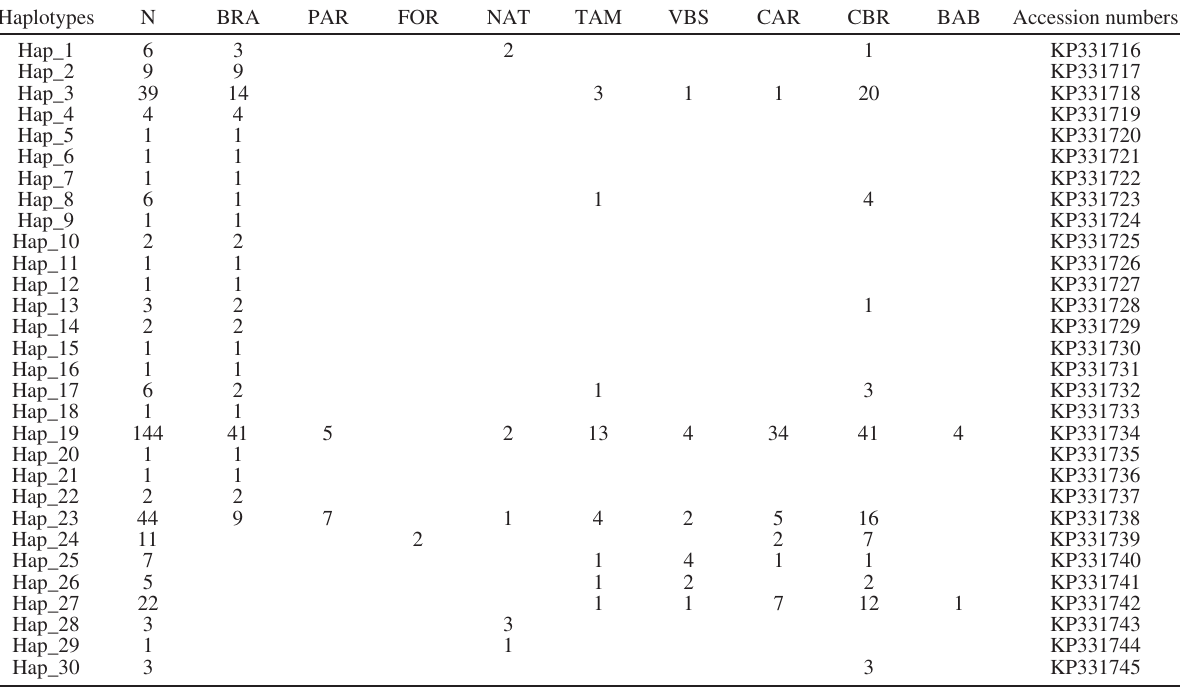
Table 5. – Distribution and frequency of haplotypes generated from fragment of mtDNA control region in E. itajara population units on coast of Brazil; BRA, Bragança; PAR, Parnaíba; FOR, Fortaleza; NAT, Natal; TAM, Tamandaré; VBS, Vaza Barris; CAR, Caravelas;